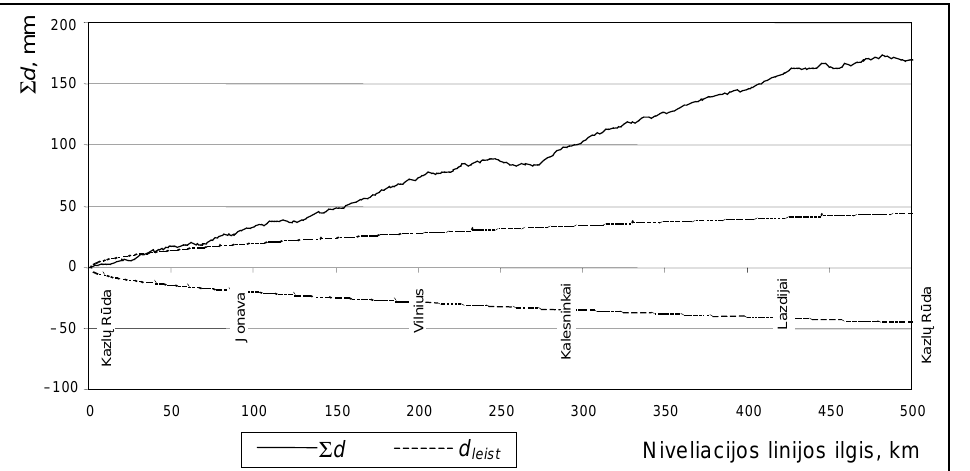
Fig 1. Accumulation of heights differences incoincidences in the fifth